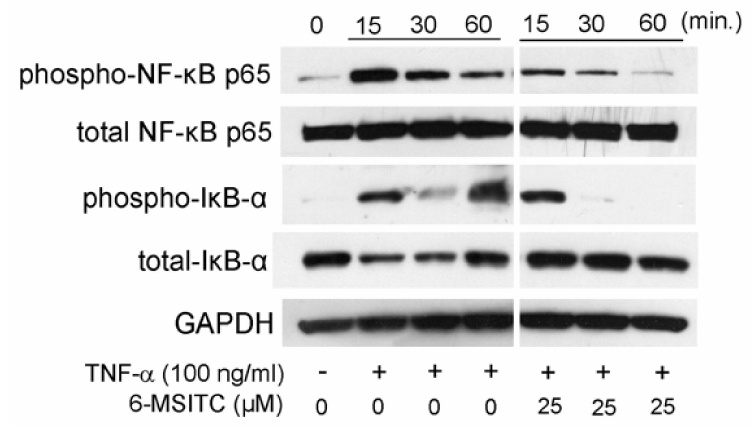
Figure 4. 6-MSITC mediated inhibition of a NF- κ B pathway in TNF- α stimulated TR146 cells. After pretreatment with 6-MSITC (25 µ M) for one hour, TR146 cells were stimulated with TNF- α for 15, 30, or 60 min, and then phosphorylation of NF- κ B p65 and I κ B- α , and I κ B- α degradation were determined by Western immunoblotting. The figure reports the results of a representative experiment performed three times with qualitatively comparable results.